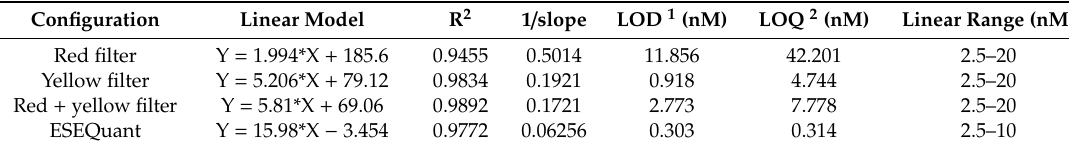
Table 1. Analytical performance of the studied QD readers.